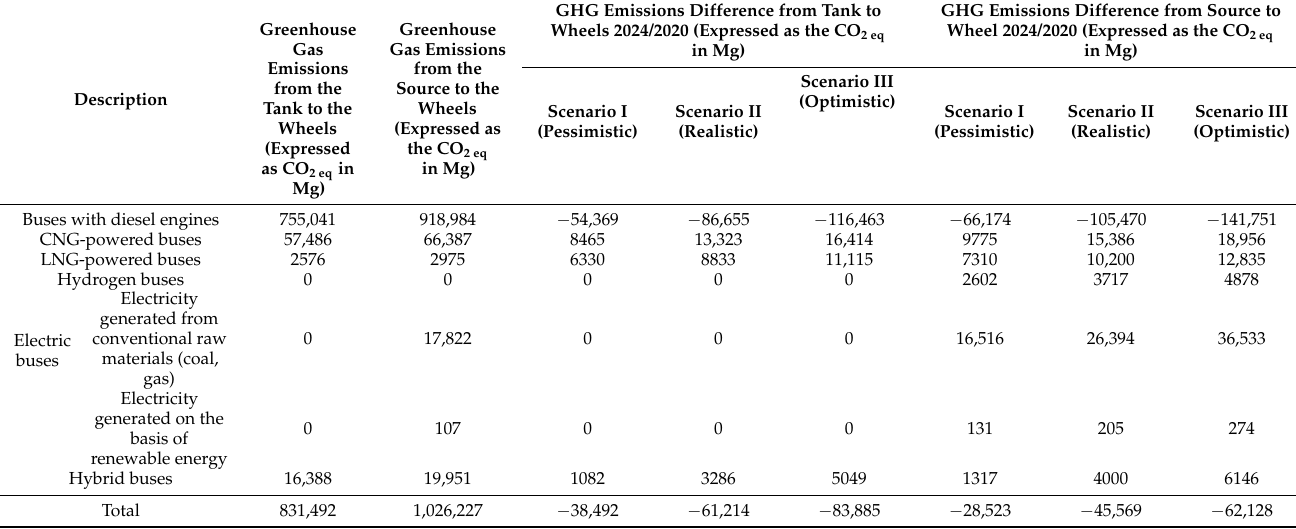
Table 7. Differences in CO 2 emissions for Scenarios I–III by the end of 2024 compared to